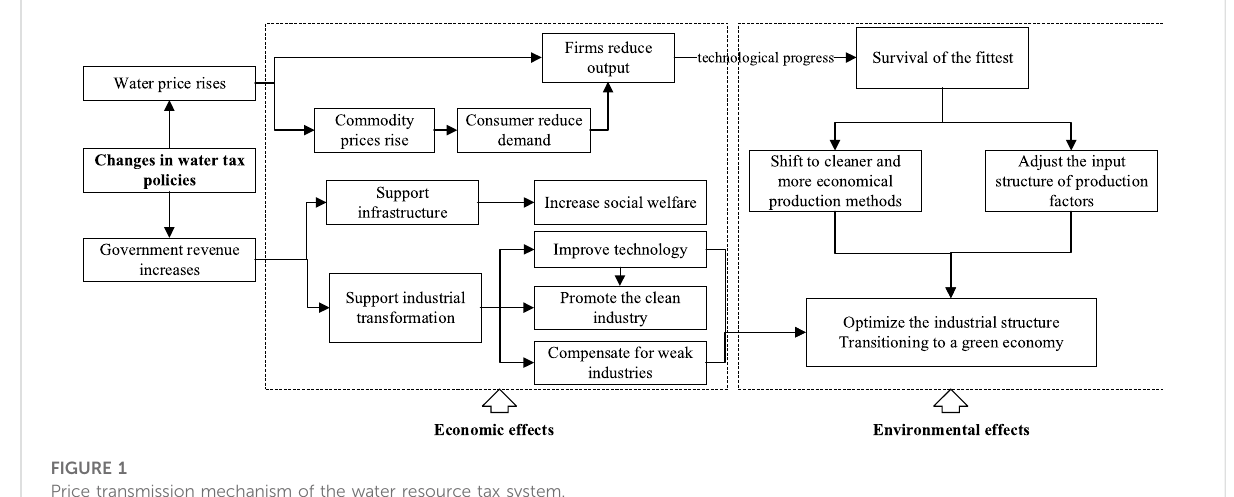
FIGURE 1 Price transmission mechanism of the water resource tax